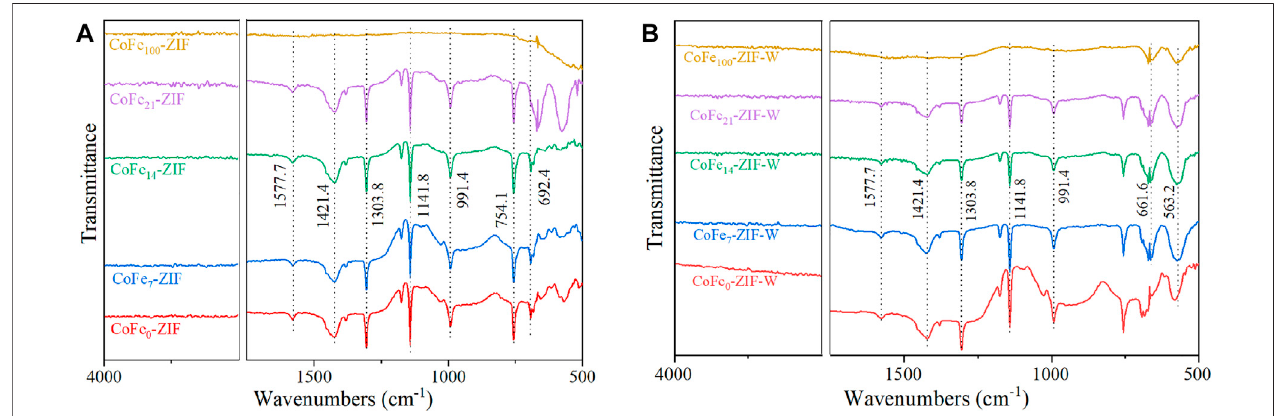
FIGURE 3 | FTIR spectra curves of catalysts under different preparation conditions (A) thermo dissolution method (B) microwave dissolution method.